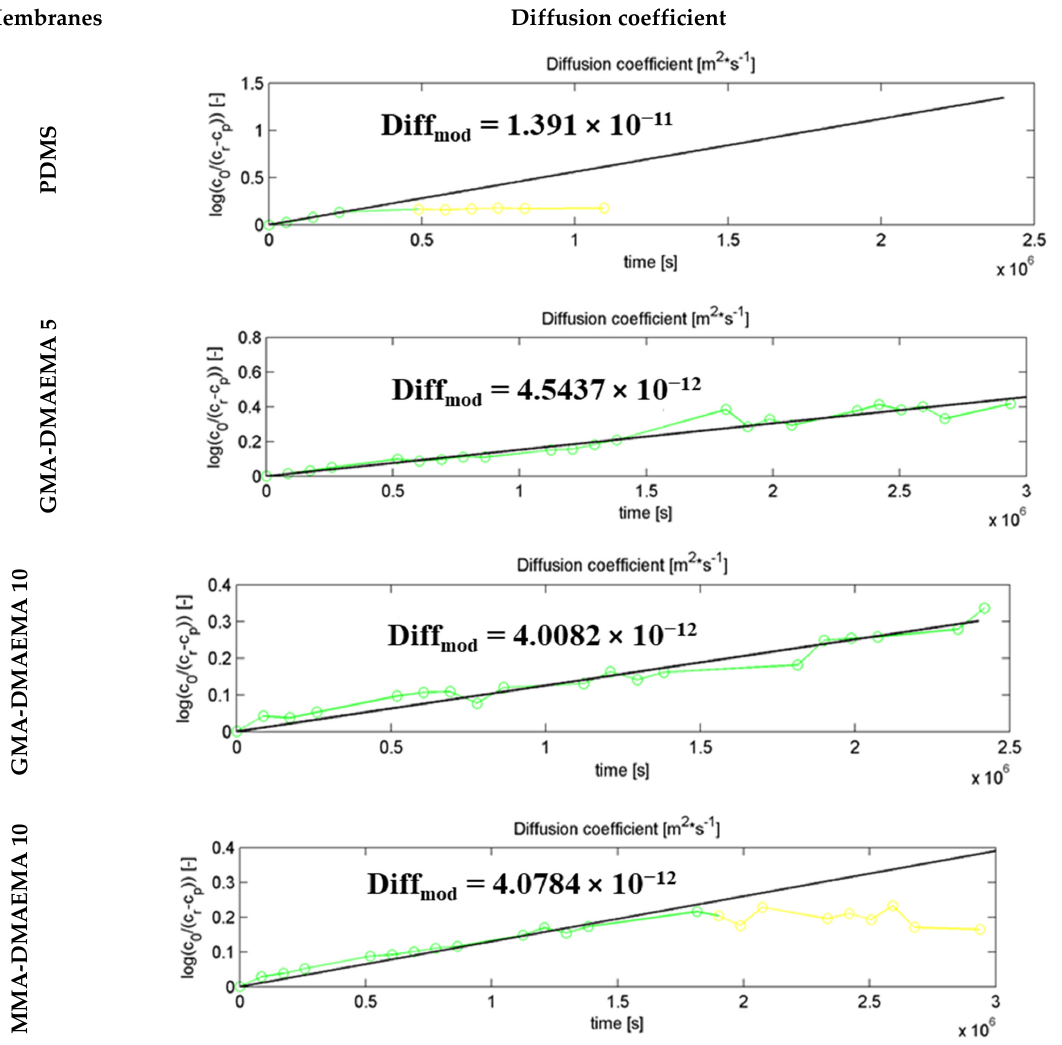
Figure 8. Experimental (linked point) and theoretical (line) diffusion coefficient of tramadol during the pertraction process with bare and modified PDMS membranes.